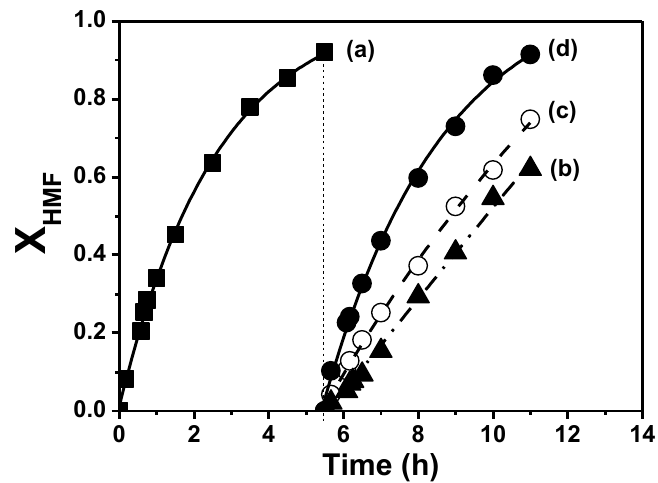
Figure 8. Catalytic performance of fresh, used and regenerated Cu/SiO 2 -PD in the liquid-phase HMF hydrogenation at T = 393 K, P H2 = 15 bar, C 0 HMF = 0.13 M: (a) fresh catalyst, (b) used catalyst, (c) after